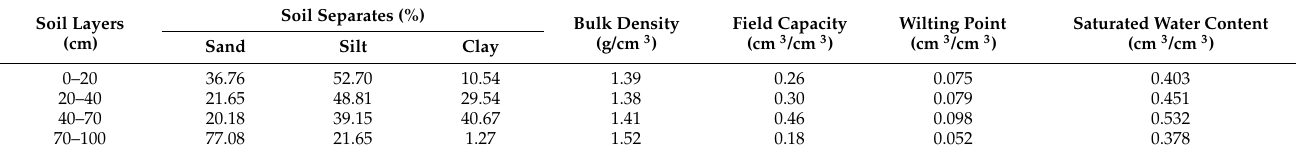
Table 2. Soil particle composition and parameters of soil hydraulic